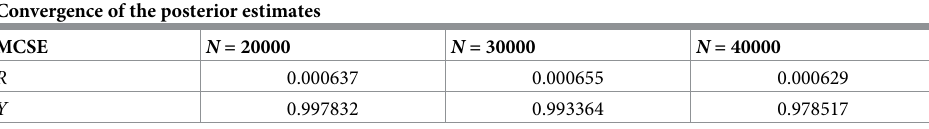
Table 2. MCSEs of posterior means of weights and weekly hidden cases in Scenario